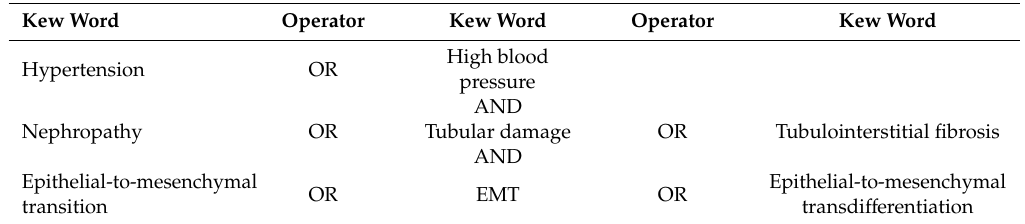
Table 1. PICO strategy used for the literature